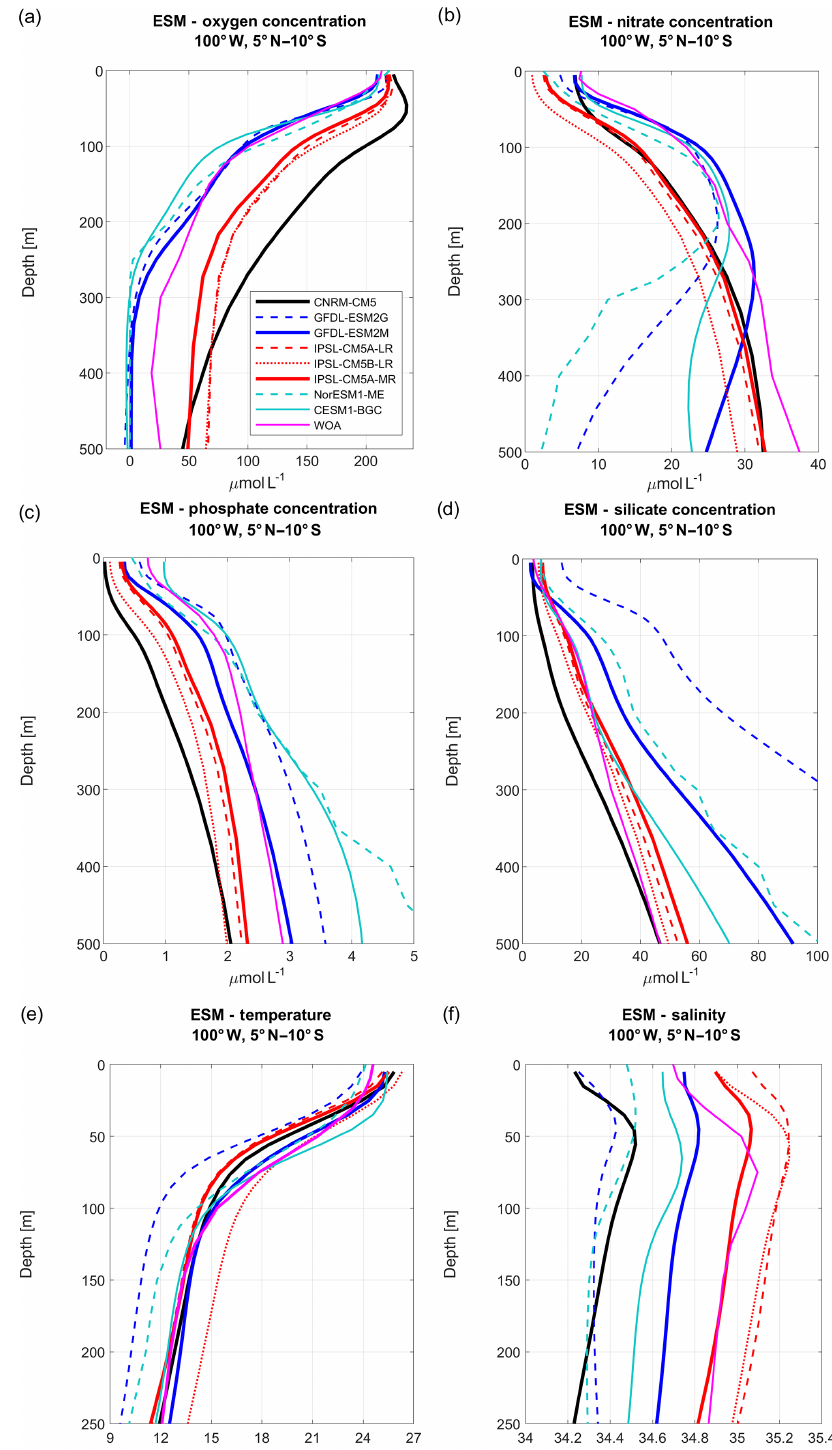
Figure 1. Vertical profiles of (a) oxygen, (b) nitrate, (c) phosphate, (d) silicate concentrations, (e) temperature, and (f) salinity in the eastern equatorial Pacific Ocean for eight Earth system models (ESMs: CNRM-CM5 (black line), GFDL-ESM2M (blue line), GFDL-ESM2G (blue dashed line), IPSL-CM5A-MR (red line), IPSL-CM5A-LR (red dashed line), IPSL-CM5B-LR (red dotted line), CESM1-BGC (cyan line), Nor-ESM1-ME (cyan dashed line)). All values are averaged along 100 ◦ W between 5 ◦ N and 10 ◦ S. The three selected models are shown in thick colored lines. WOA observations are marked by magenta lines. ESM biogeochemical variables are averaged for the 1981–2005 period, while ESM temperature and salinity are averaged for the 1950–2005